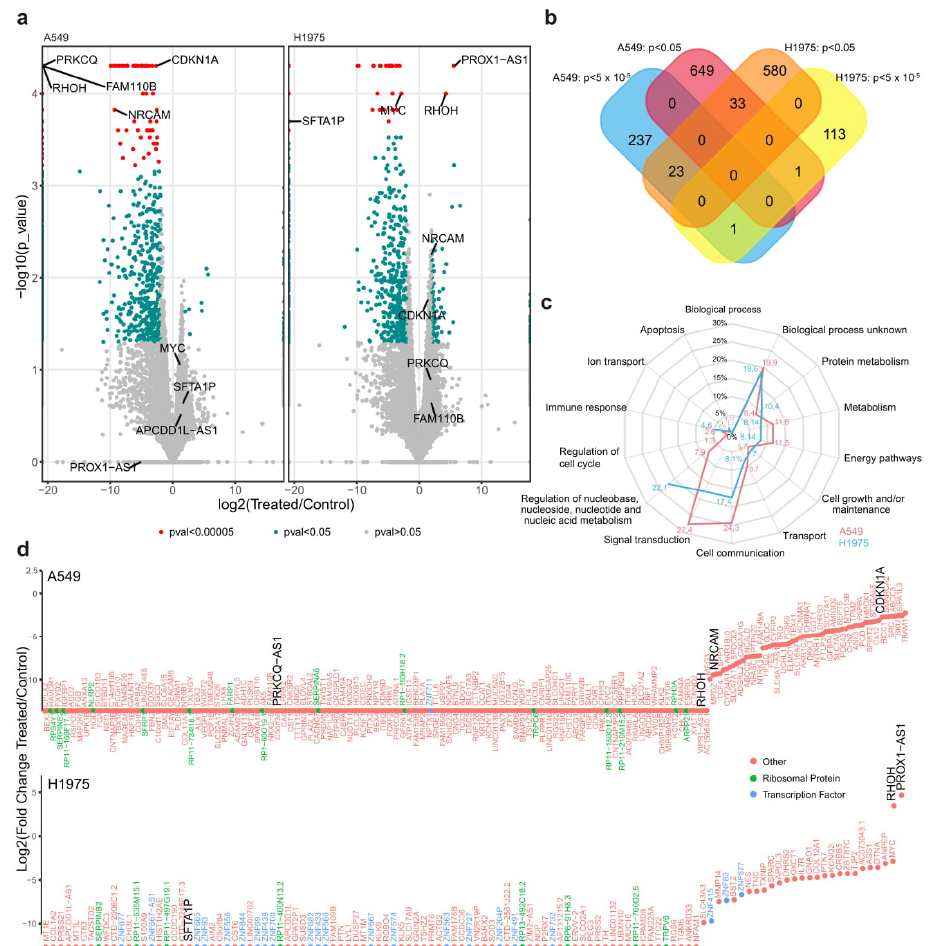
Figure 6. ( a ) Vulcan plots for the A549 and H1975 gene expression. Data shows mostly up-regulation or down-regulation of genes in the siRNA XIST treated samples in comparison to non-treated ones (left of center = down-regulation, right of center = up-regulation), with a handful of genes shown to be very significantly up or down-regulated. ( b ) Venn diagram showing the total genes significantly dysregulated for both cell lines. ( c ) The biological processes where the down-regulated genes are found. Most of the dysregulated genes in both cells lines are playing a significant role in signal transduction (27.4% for the A549), cell-to-cell communication (24.3% for the A549 and 17.4% for the H1975) and regulation of nucleic acid metabolism (22.1% for the H1975 and 7.9% for the A549), ( d ) Ranking of all the highly significantly differentially expressed genes (DEGs) in both cell lines ( p < 5 × 10 − 5 ). Overall, 944 genes were significantly dysregulated after the treatment with the siRNA XIST for the A549 cell line. From thse genes, the 683 were downregulated at p < 0.05, and 261 were highly- significantly down-regulated at p < 5 × 10 − 5 . In the H1975, 751 genes were significantly dysregulated after the treatment with the siRNA XIST. 536 genes were downregulated at p < 0.05 and 113 significantly down-regulated p < 5 × 10 − 5 with two genes to present and highly significant upregulation after the transfection. The DEGs are presented as supplementary table. The two cell lines had 34 downregulated genes in common with p < 0.05, 24 downregulated genes with p < 5 × 10 − 5 , and one gene ( RHOH ) that was up-regulated in the H1975 and down-regulated for the A549 (Figure 6b). Subsequent analysis of the differentially expressed genes (DEGs) using FunRich revealed distinct biological processes for the two cell lines, including signal transduction, cell communication, metabolism, and energy pathways (Figure 6c). A summary of the top DEG in the A549 and H1975 cell lines respectively is shown in Figure 6d. In both cell lines, XIST was downregulated in agreement with previous studies that siRNA was used [6,27,31,32]. PROX1AS1 (antisense RNA) and RHOH (a negative regulator of cell growth and